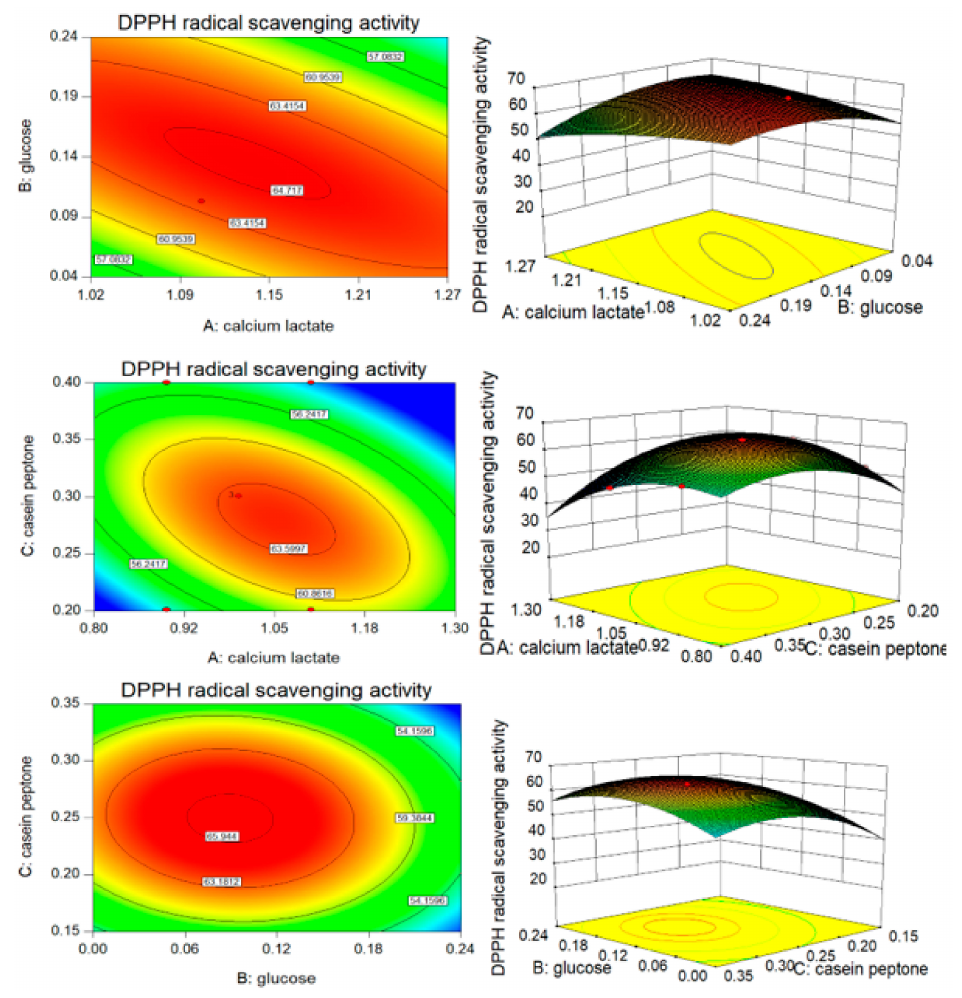
Figure 4. Contour plots and response surface plots of calcium lactate (A), glucose (B), and casein peptone (C) for the DPPH radical scavenging rate (Y 2